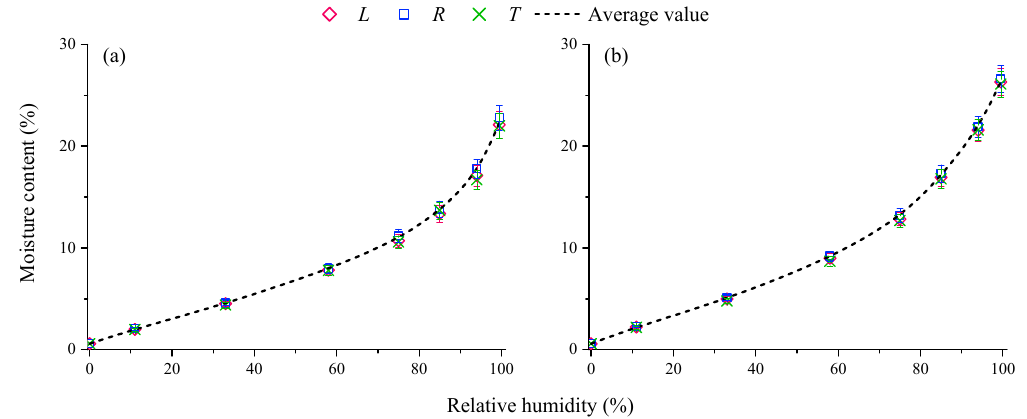
Figure 1. Moisture contents of poplar ( a ) and Chinese fir ( b ) at a series of relative humidity.